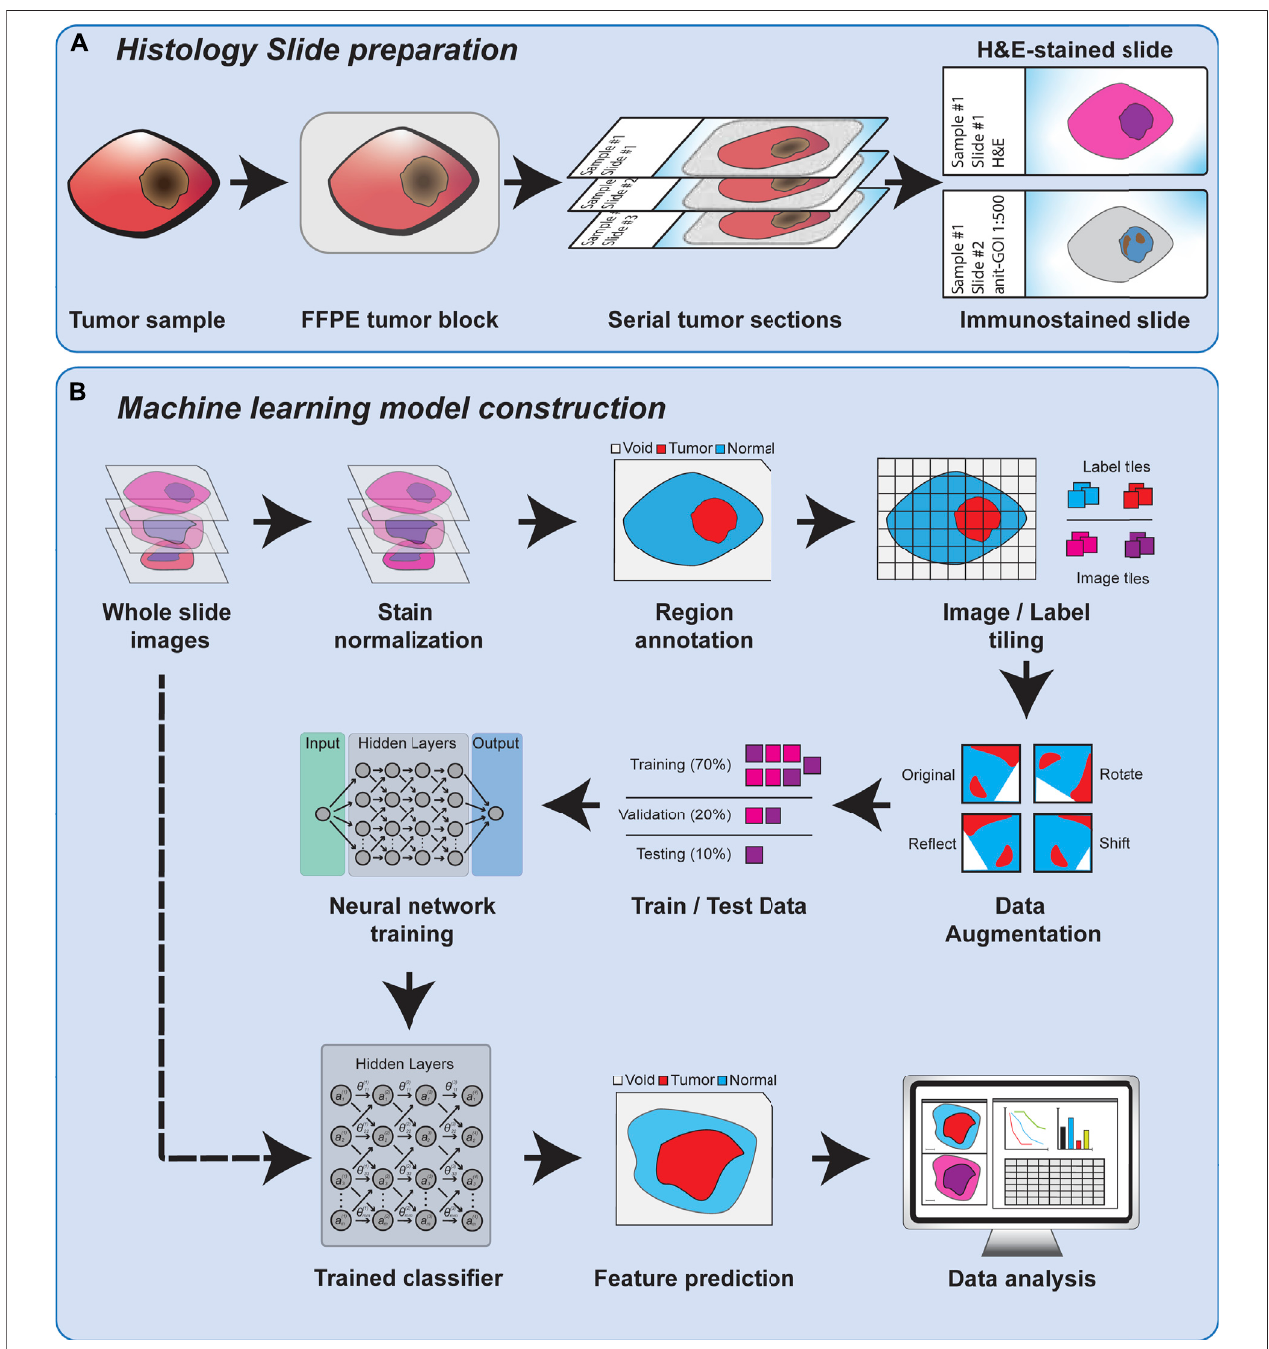
FIGURE 2 | An overview of histology slide preparation and machine learning model construction process.